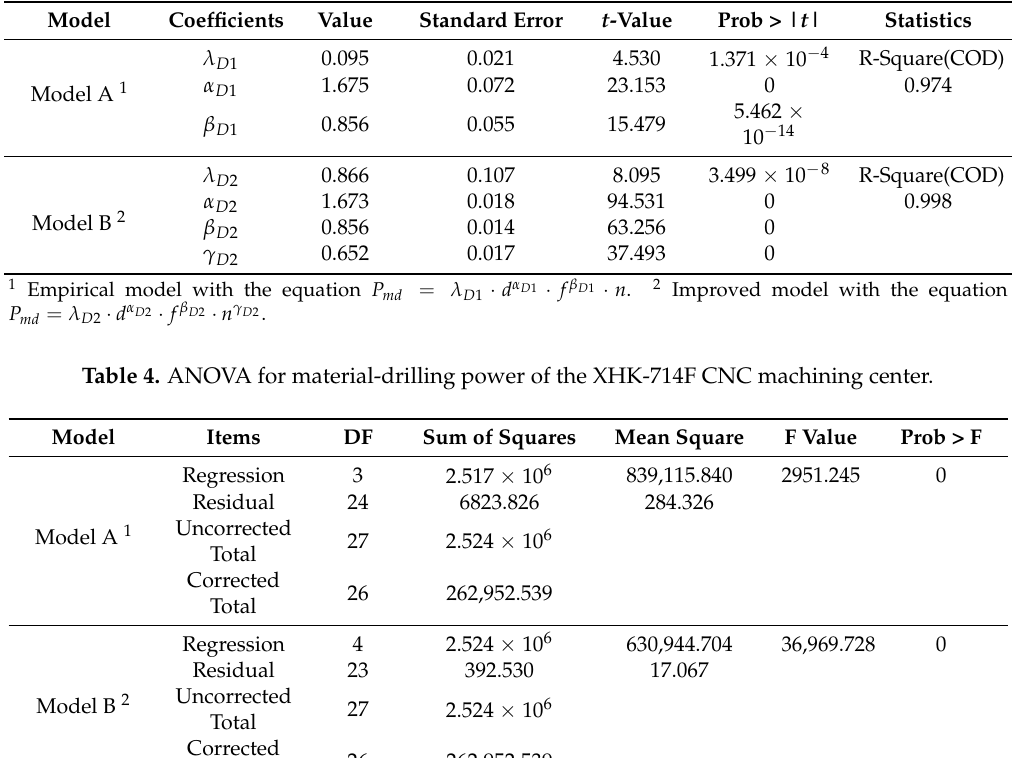
Table 3. Curve fitting results for material-drilling power of the XHK-714F CNC machining center. Model